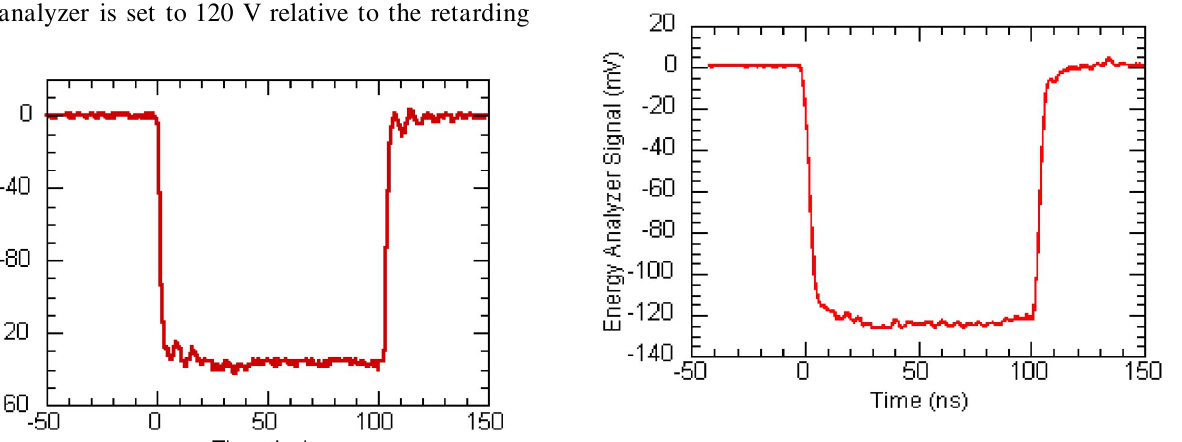
FIG. 6. (Color) A typical output pulse signal from the energy analyzer when the energy analyzer is at the position of the beam